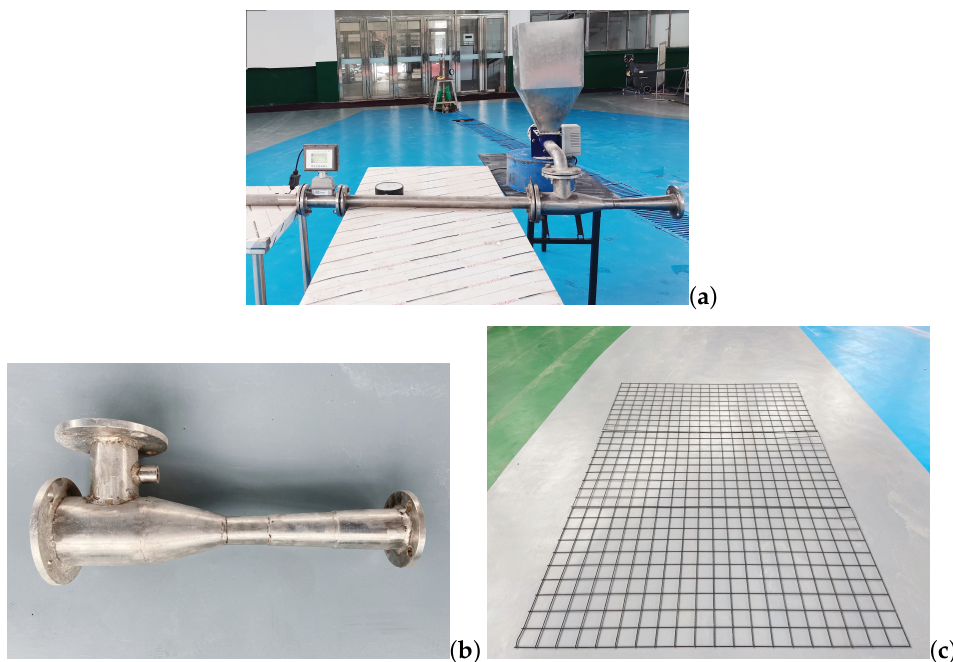
Figure 3. Experimental setup: ( a ) particle-laden flow system, ( b ) injector, and ( c ) particle collec- tion